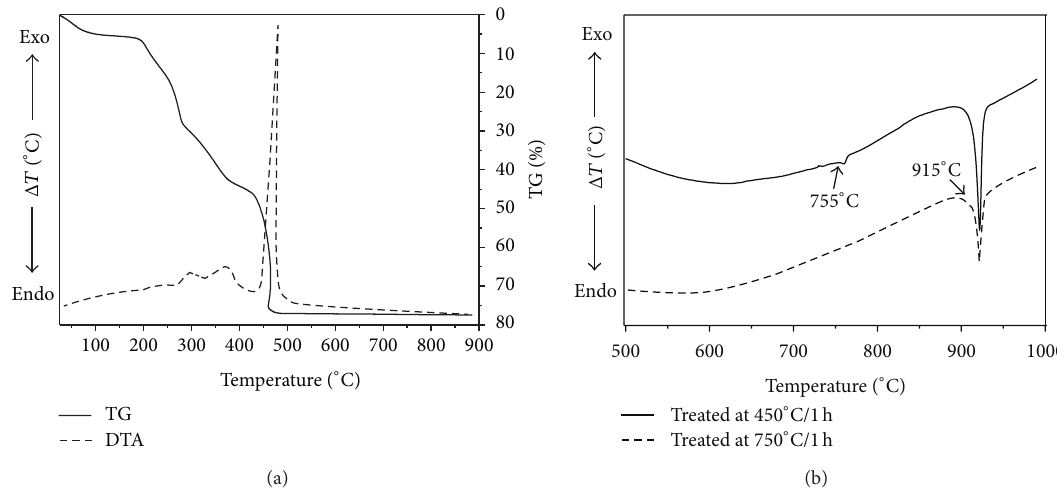
Figure 1: (a) Simultaneous DTA/TG curves of the resin dried at 100 ∘ C/24 h. (b) DTA curves obtained after thermal treatments at 450 ∘ C/1h and 750 ∘